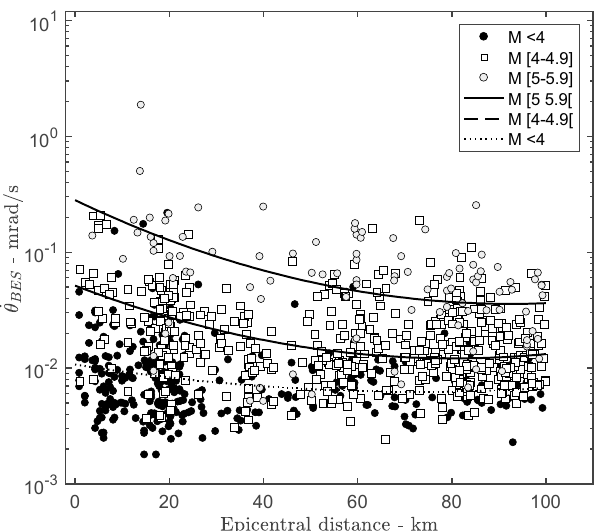
Figure 6. Attenuation of the rotation rate at the bottom of the ANX building with respect to the epicentral distance for several magnitude bins.